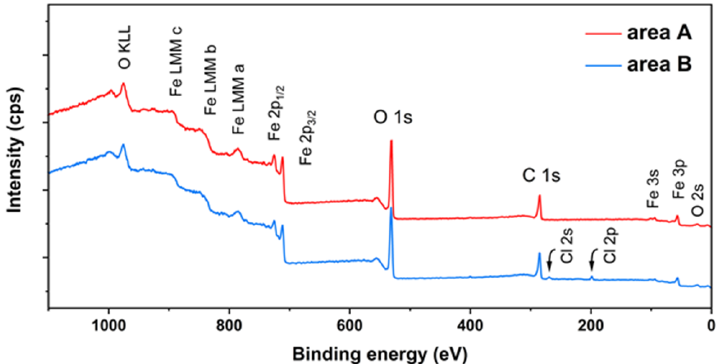
Figure 10. XPS survey of archaeological steel with proanthocyanidins.